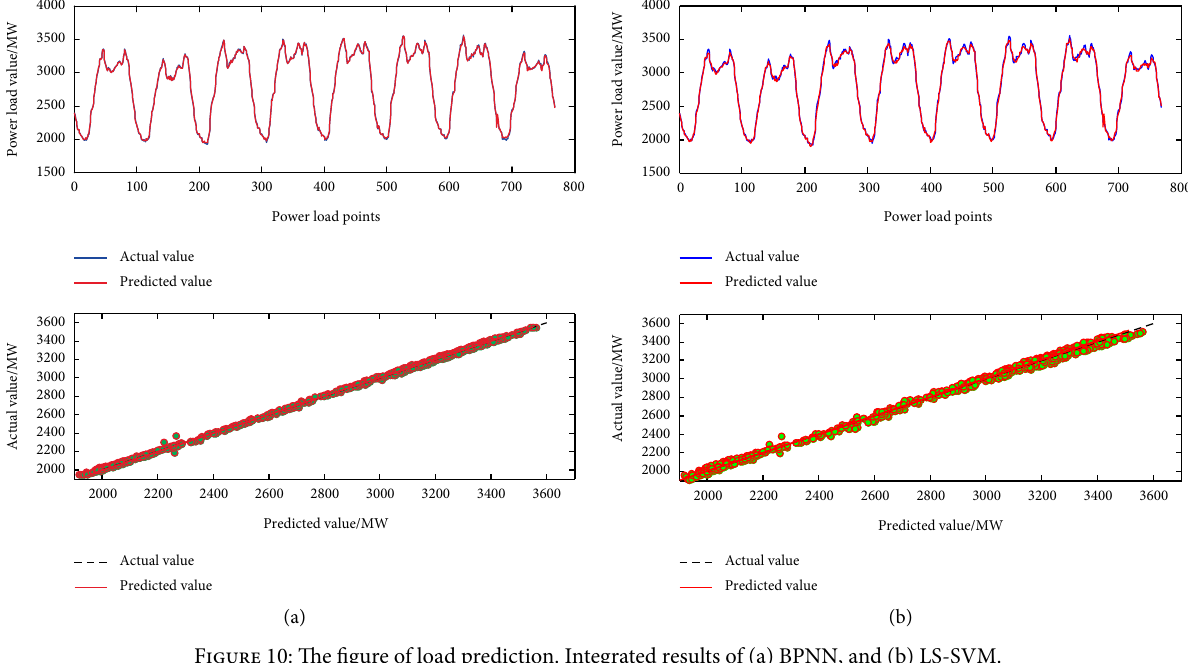
Figure 10: The figure of load prediction. Integrated results of (a) BPNN, and (b) LS-SVM.